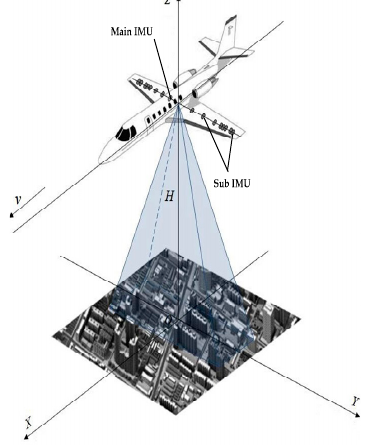
Figure 1. Airborne ground-observation system.